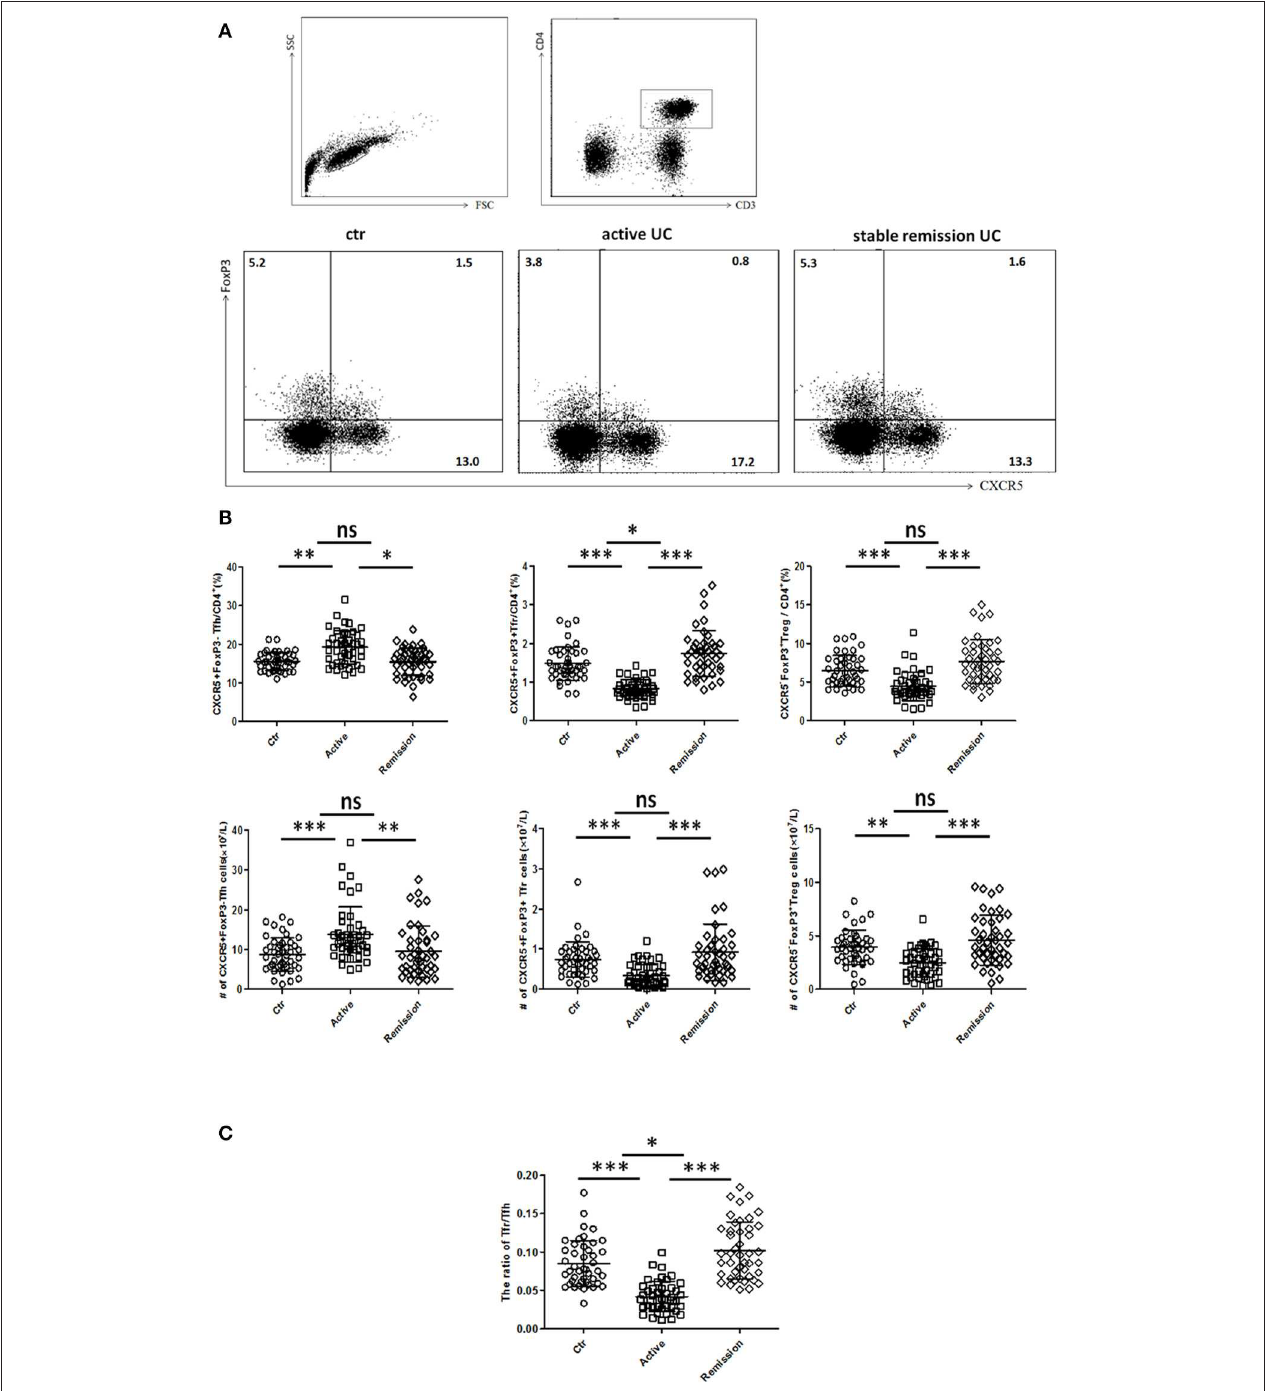
FIGURE 1 | Flow cytometry analysis of circulating TFR and TFH in UC patients and healthy controls. Peripheral blood from UC patients in active stage ( n = 44), stable remission ( n = 44) and HC ( n = 44) was collected, and then TFH, TFR cells were measured by FACS through staining of CD3, CD4, CXCR5, and FoxP3. (A) Representative dot plots for flow cytometry used in this study. TFR, TFH, and Treg were defined as: CD4 + CXCR5 + FoxP3 + cells (TFR), CD4 + CXCR5 + FoxP3 − cells (TFH), and CD4 + CXCR5 − FoxP3 + cells (Treg). Numbers show the percentage of TFR, TFH, and Treg in CD4 + lymphocytes. (B) Comparison of average percentage (up) and absolute numbers (bottom) of TFR, TFH, and Treg among three groups. (C) The comparison of ratios of CD4 + CXCR5 + FoxP3 + TFR cells to CD4 + CXCR5 + FoxP3 − TFH cells in three groups. Symbols represent individual subjects and bars show the mean ± SD. * p < 0.05; ** p < 0.01; *** p < 0.001; ns, not